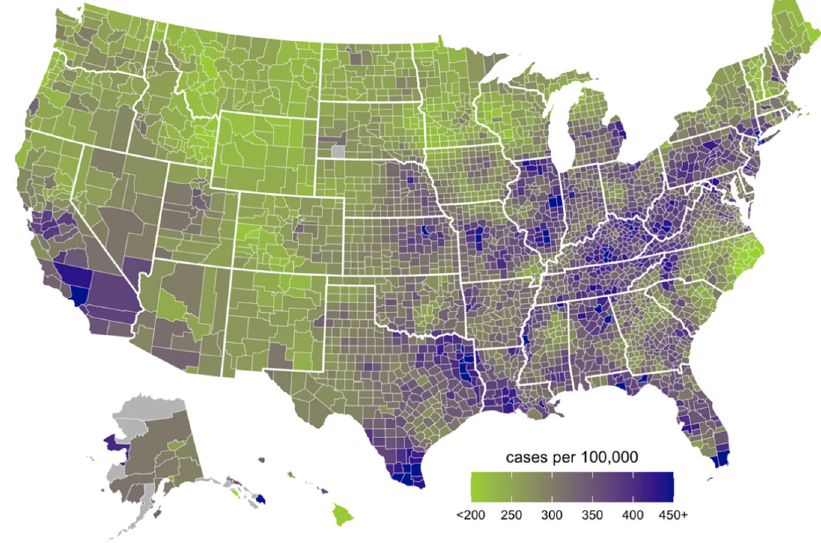
Fig. 2 Geographical variation in 2012 PD Incidence among 6,866,623 Medicare bene fi